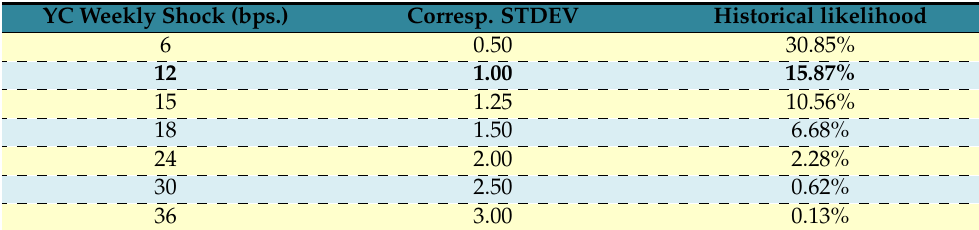
Table 9. Likelihood of principal components’ weekly yield curve shocks on 25 February 2022. YC Weekly Shock (bps.) Corresp.